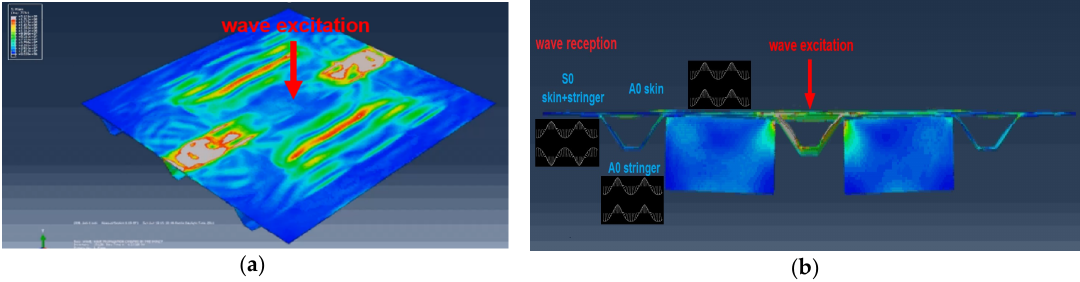
Figure 3. FE model of a stiffened composite panel: ( a ) 3D view; ( b ) cross-sectional view showing multi-mode wave propagation and acoustic inter-talk between the skin, stringer, and shear ties.